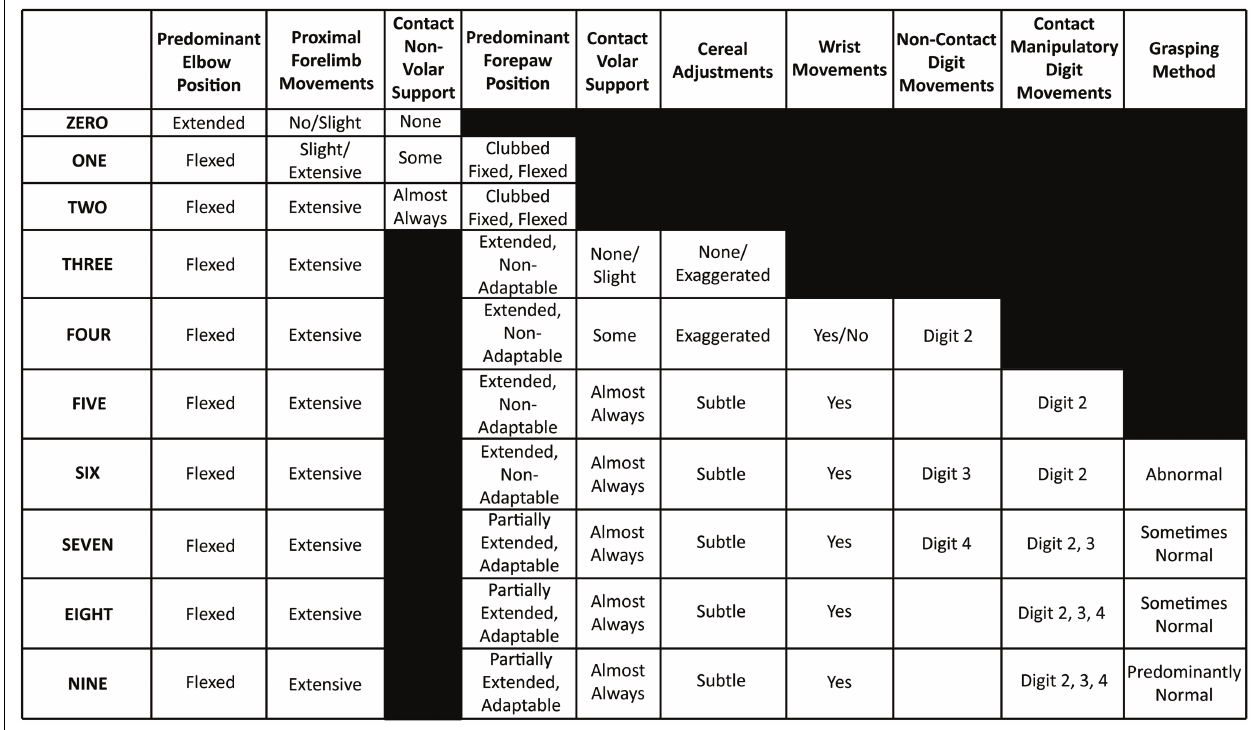
Frontiers in Neurology | Movement